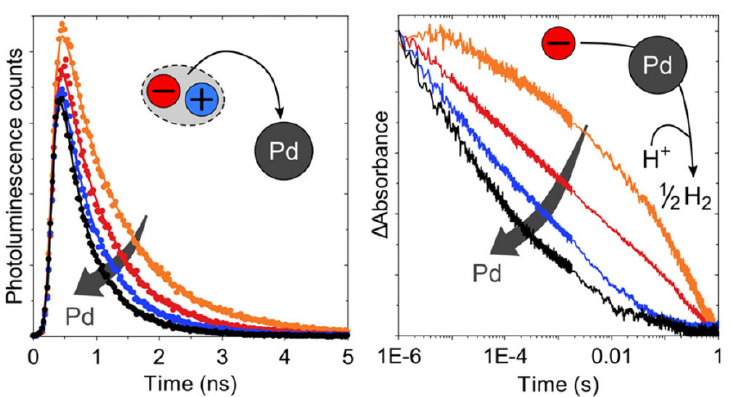
Figure 43. Time-resolved single photon counting data for F8BT (left) and TA data for P10 (right) for samples with increased palladium content [Figure from ref. [18] under CC-BY 3.0 International Li- cense].